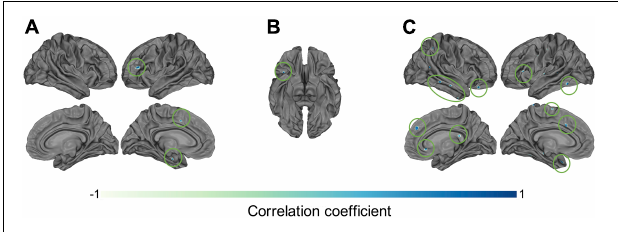
FIGURE 6 | Correlational results between C1 and C2 values and patients’ clinical information. Pearson correlation results between patients’ (A) C1 values and negative symptom scores on the SANS ( p < 0.05), (B) C2 values and positive symptom scores on the SAPS ( p < 0.05), and (C) C1 values and medication dosages (olanzapine equivalent in mg), p <